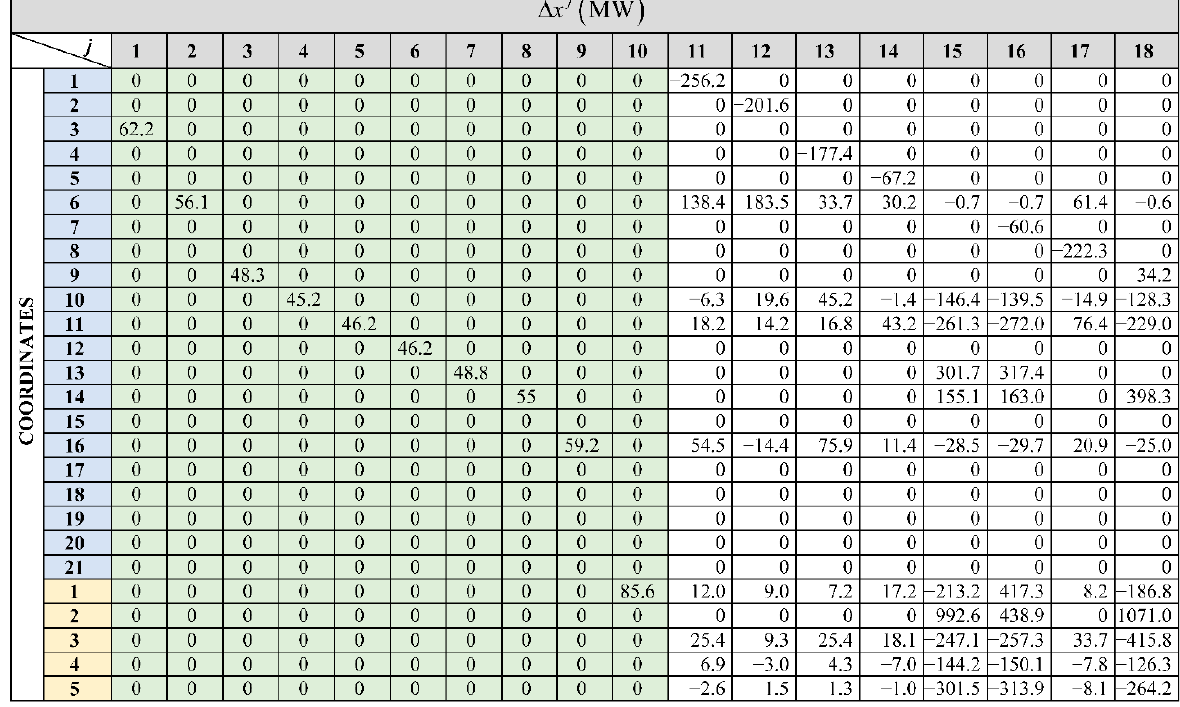
Figure 11. Vectors describing the possible increase and decrease in regional capacities for which the sum of squared errors increases by no more than 1%. sum of squared errors increases by no more than